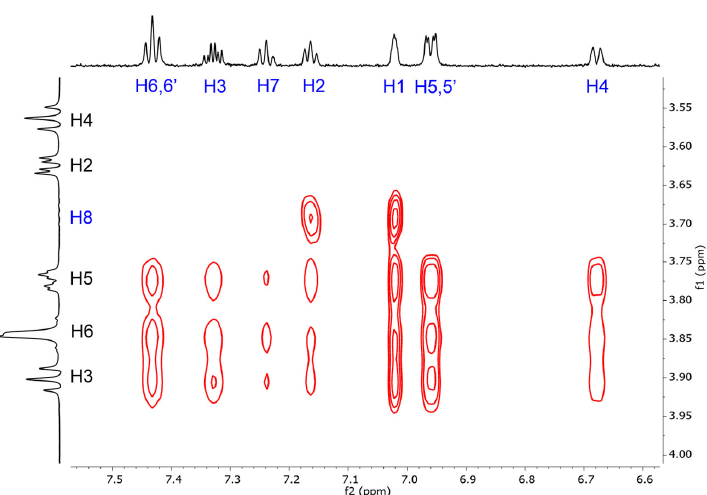
Figure 5. The ROESY NMR spectrum of fenoprofen-BCyD 1:5 complex in 90% H 2 O/10% methanol- d 4 . Assignation of the signals in blue is for fenoprofen, in black is for BCyD.